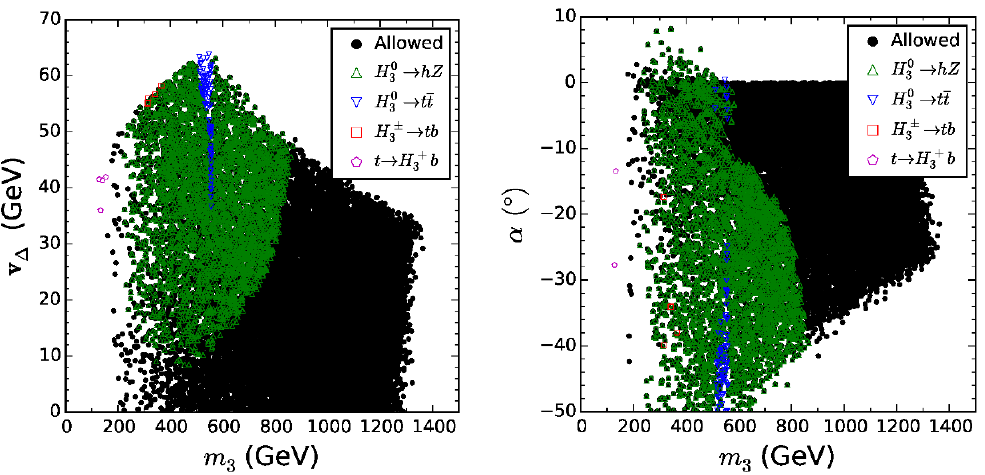
Figure 3 . Distribution of survived points shown in the v (right). The green, blue, red, and purple points are excluded by the H 0 and t ! H + b searches 3